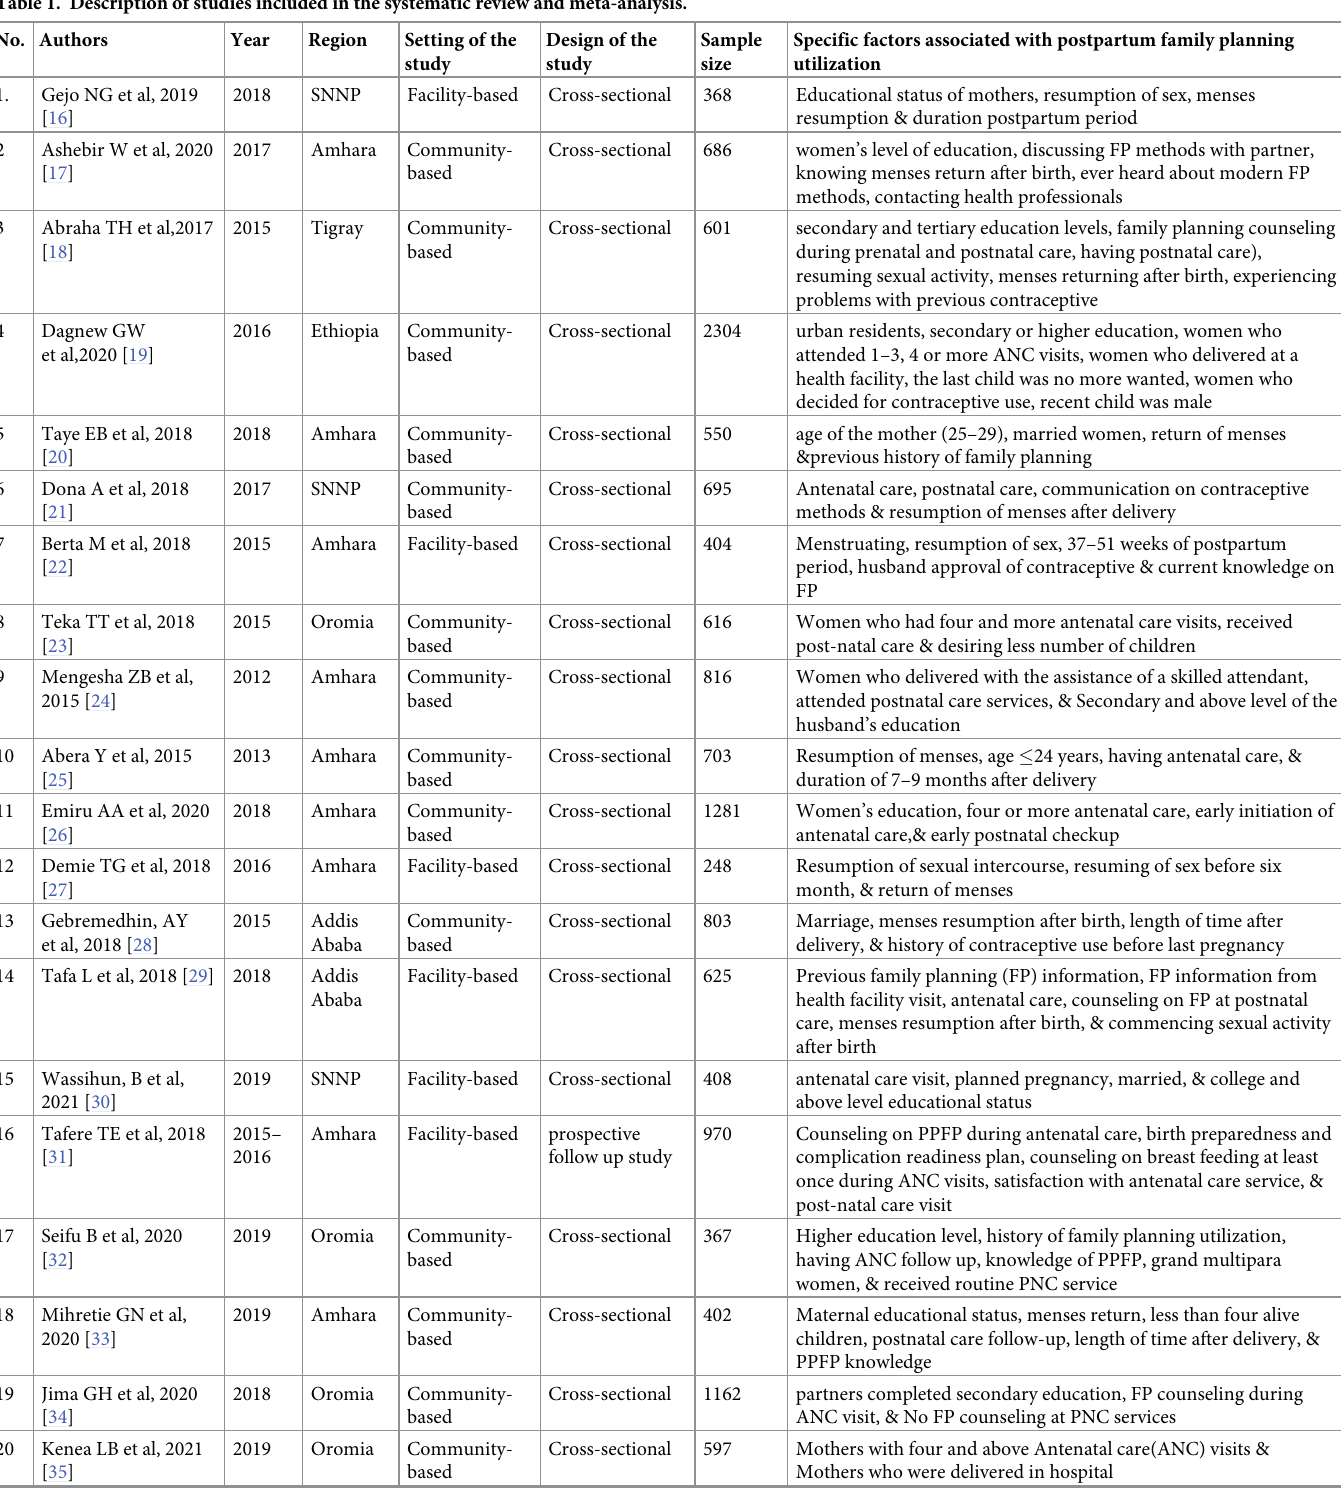
Table 1. Description of studies included in the systematic review and